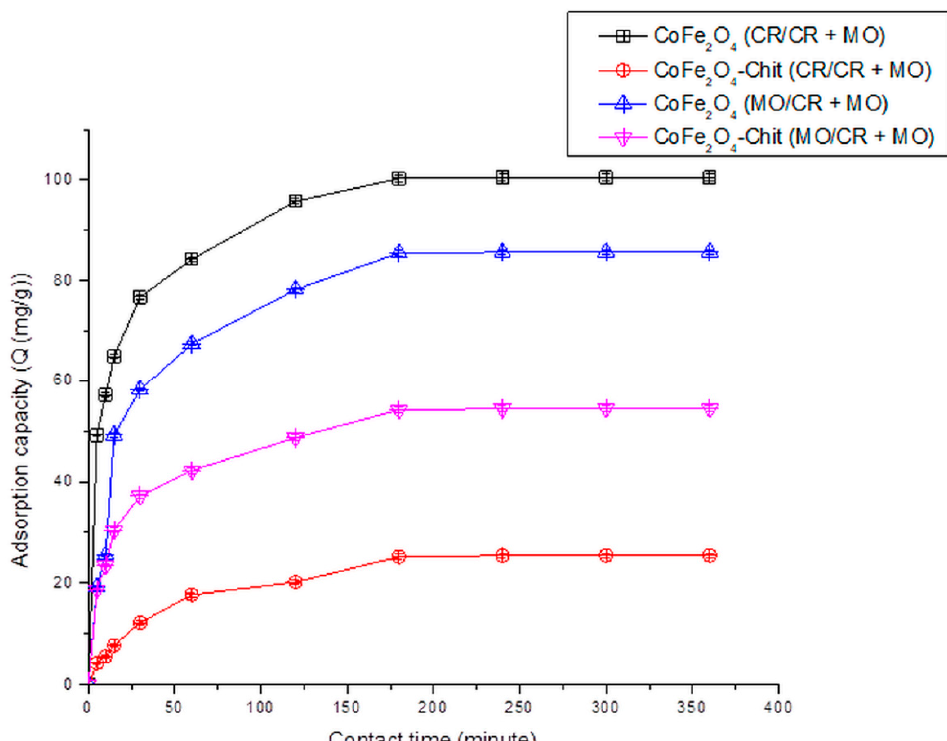
Figure 14. The variation of CoFe 2 O 4 /CoFe 2 O 4 –Chit adsorption capacity versus contact time for the CR and MO adsorption from binary solution (100mg/L CR + 100 mg/L MO) (pH = 2.22).